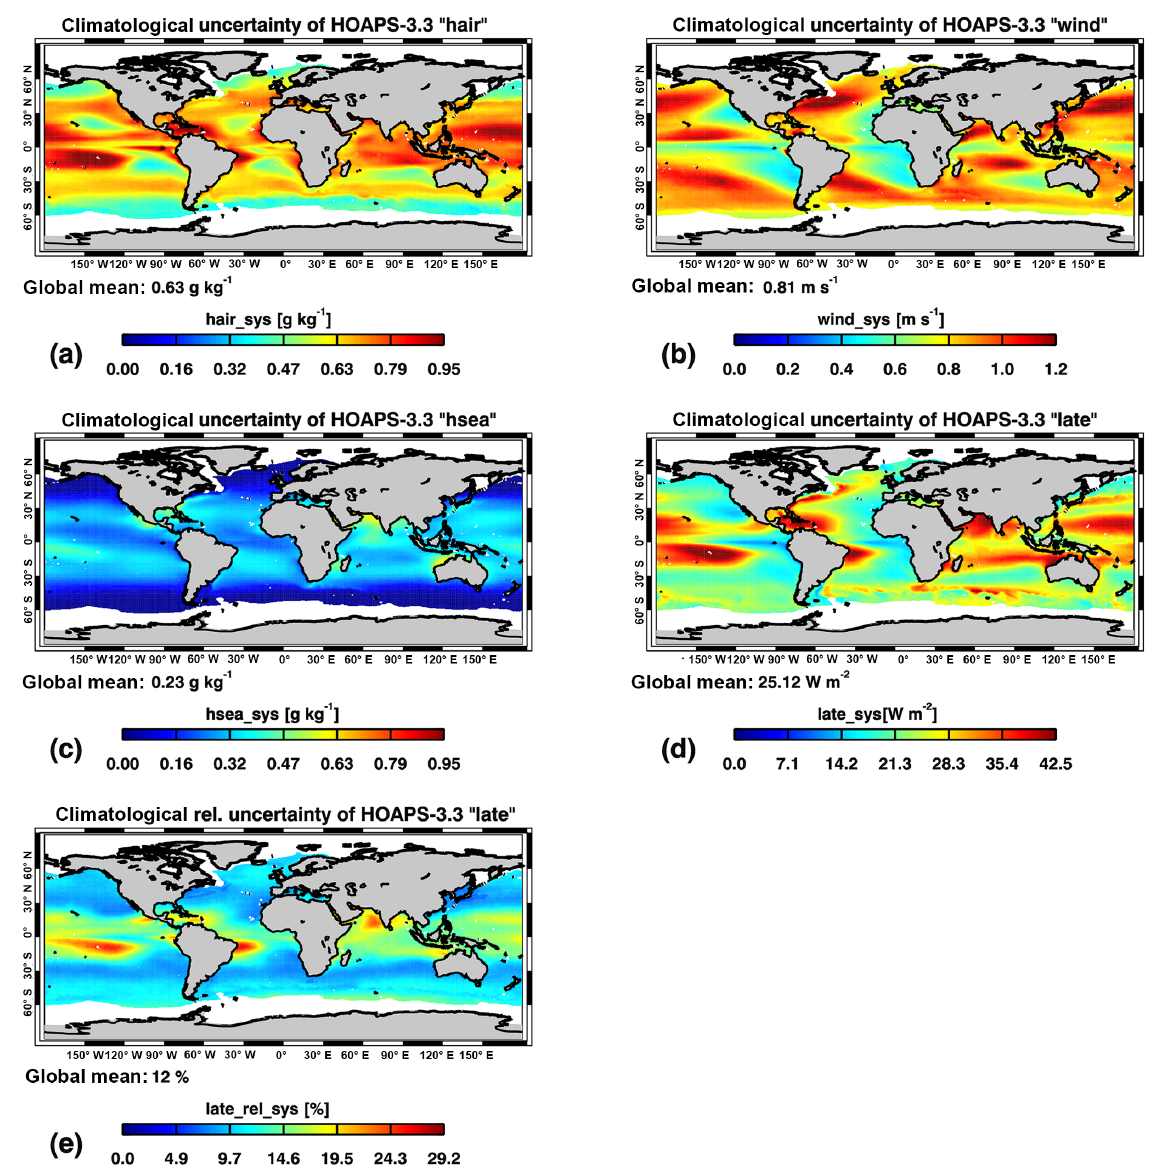
Figure 4. HOAPS 3.3 climatological total uncertainties ( E clim ) of (a) q a (“hair”), (b) U (“wind”), (c) q s (“hsea”), and (d) LHF (“late”). E clim is defined as the mean root-mean-squared sum of E sys , E ran retr , and E smp (1988–2012). (e) Climatological mean relative E clim (LHF) with respect to its natural variability. This variability is defined as the range between the 5th and 95th percentile of instantaneous LHF between 2000 and 2008. The global averages (text strings) were derived by considering a latitudinal cosine dependency. All patterns result from the multi-dimensional bias analyses and subsequent uncertainty propagations described in Sects. 3.2 and 3.4. Note that the colour bar ranges of panels (a) and (c) are identical to allow for direct